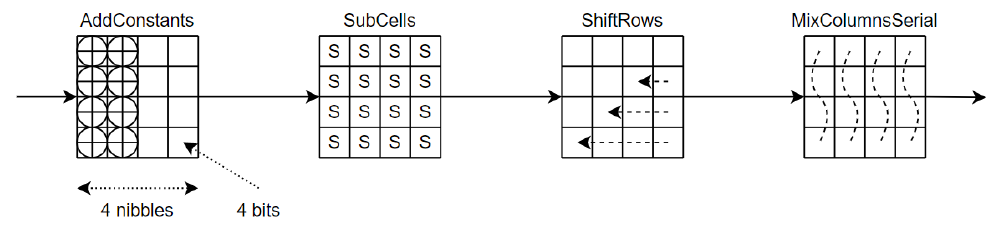
Figure 2. A round of LED composed by the functions AddConstants , SubCells , ShiftRows and MixColumnsSerial